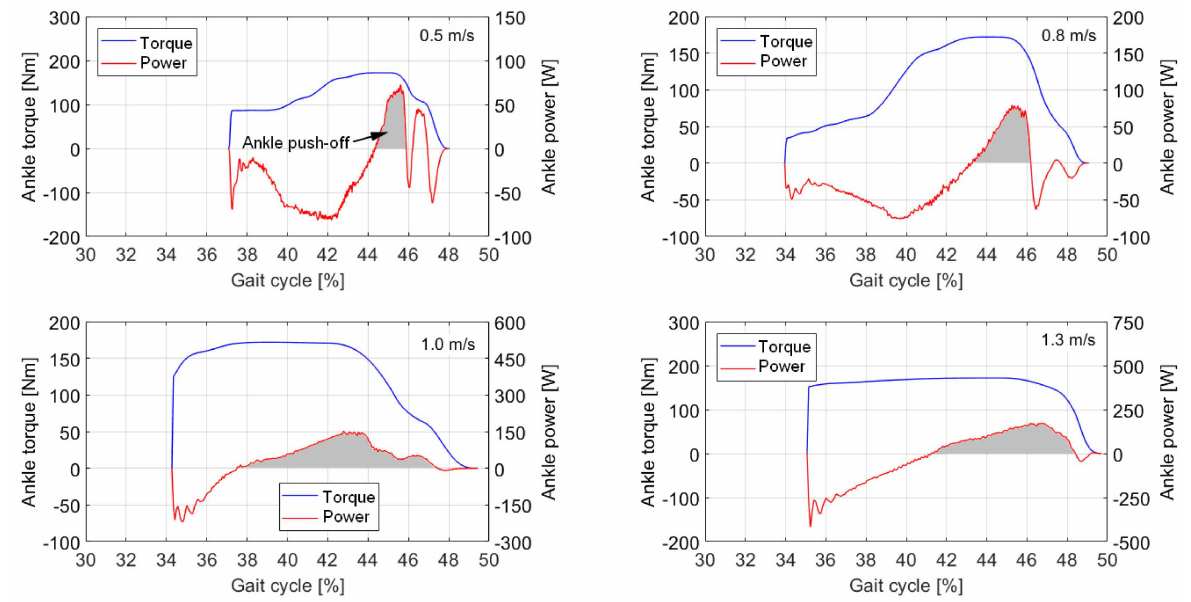
Figure 10. Ankle torque and power during the push-off phase at different walking speeds. The blue line indicates ankle torque. The red line indicates ankle power. The gray area represents the mechanical work of ankle push-off, when the ankle power is positive.